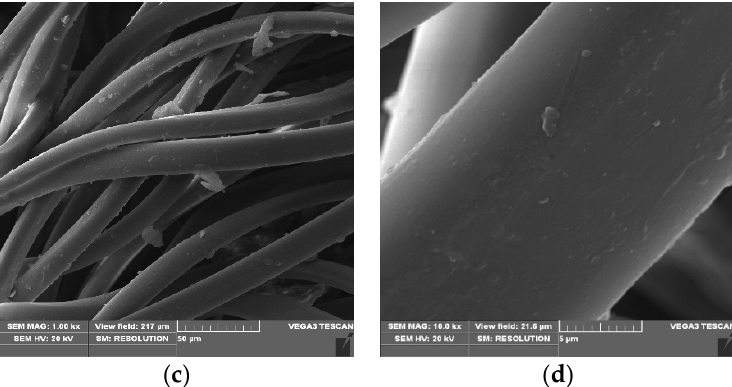
Figure 4. Scanning electron microscopy images of the PETE knitted textile samples (unmodified), magnification: 100× ( a , b : right/left side of the knitted textile sample), 1000× ( c ), 10,000× ( d ).